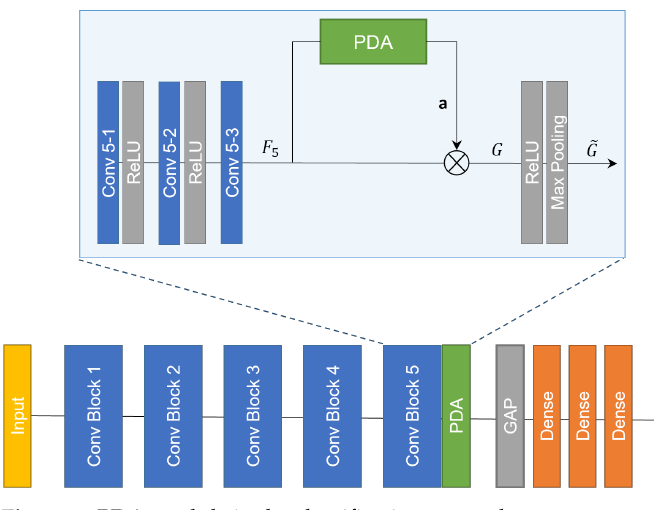
Figure 3. PDA module in the classification